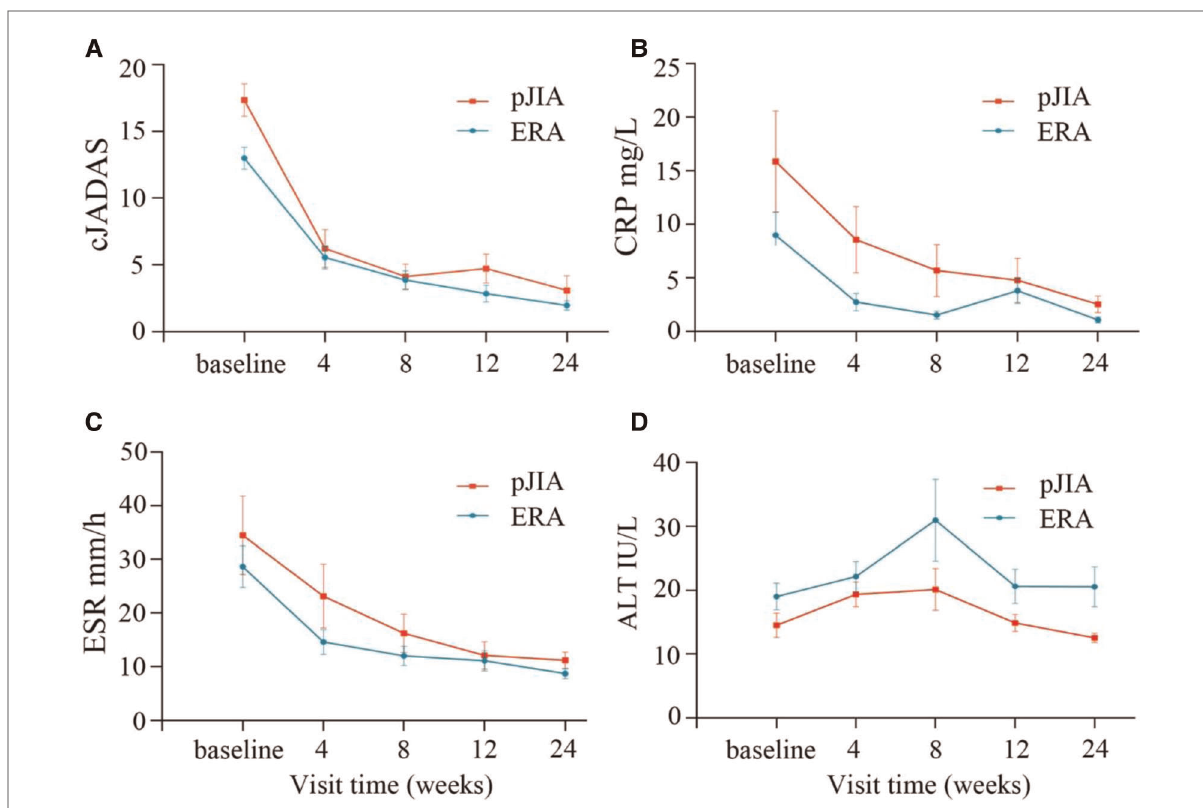
FIGURE 3 Comparison of children with pJIA and ERA. There were obvious decreased trends in cJADAS-10 ( A ), CRP ( B ) and ESR ( C ) between children with pJIA and ERA. The repeated measures analysis of variance revealed signi fi cant statistical differences in the cJADAS-10 ( A ), CRP ( B ), and ESR ( C ) between the two groups. The ALT levels were still within normal range regardless of pJIA or ERA ( D ). pJIA, polyarticular course JIA; ERA, enthesitis related arthritis; cJADAS, clinical Juvenile Arthritis Disease Activity Score; ESR, erythrocyte sedimentation rate; CRP, C reactive